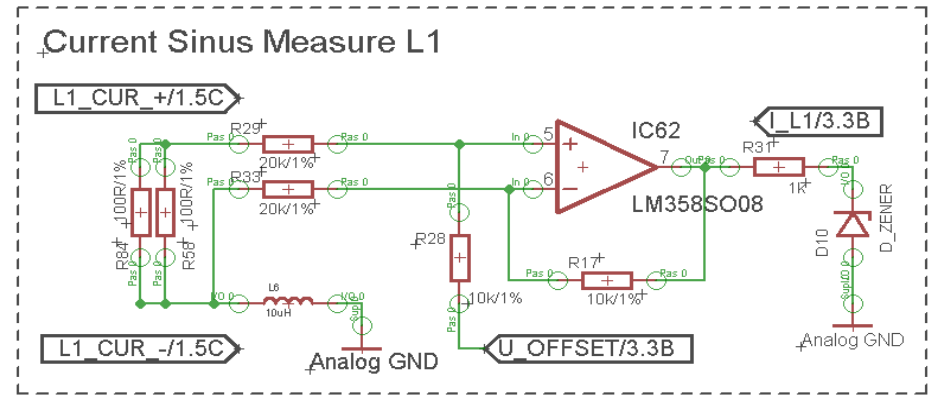
Figure 5. Current measurement and its adapter circuit.